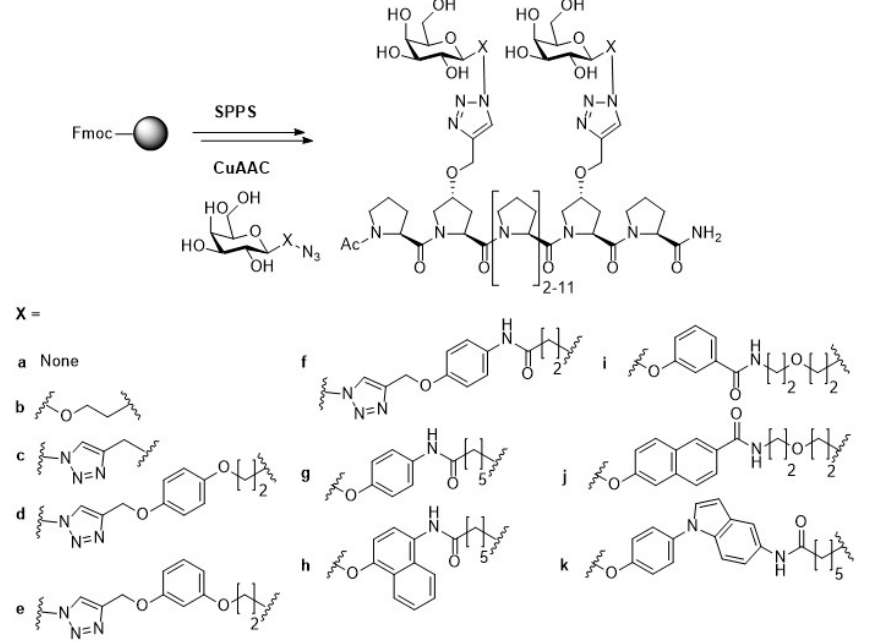
Figure 3. Design of polyproline glycopeptides with varying interligand spacing and various galactose ligands.